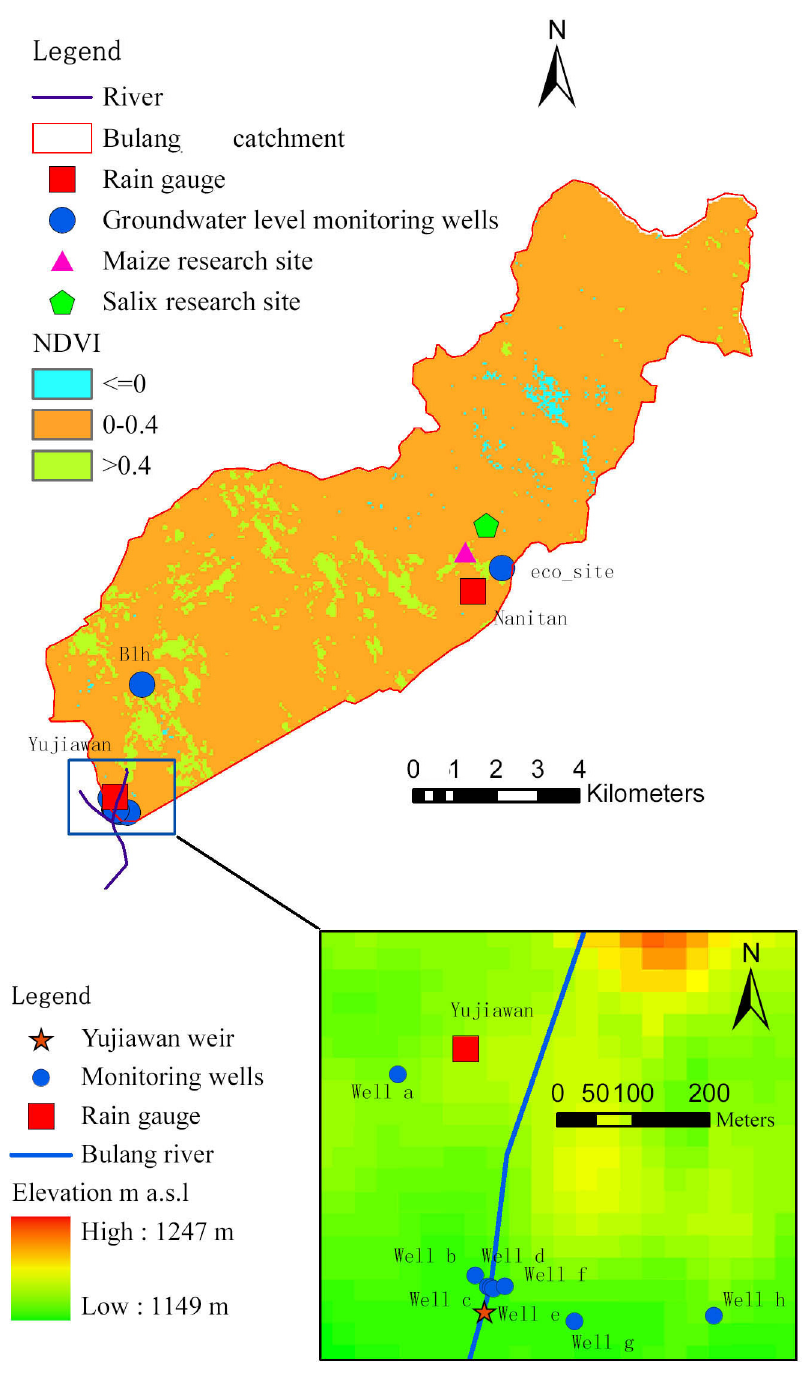
Figure 2. NDVI map of the Bulang catchment, interpretation of remote sensing data from TM on August